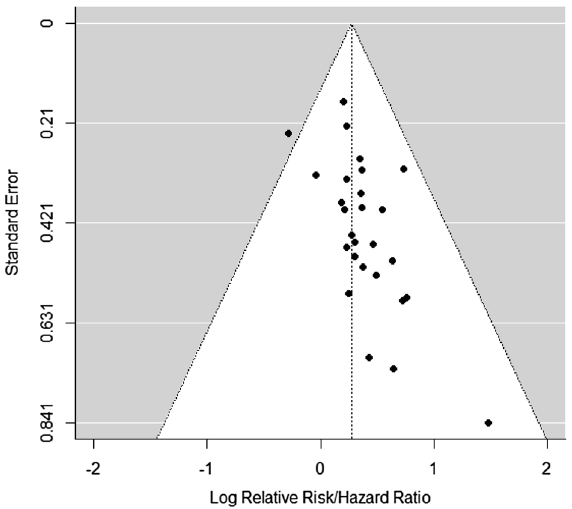
Figure 4. Funnel plot for the detection of publication bias. Data were analyzed using the frequentist meta- analysis